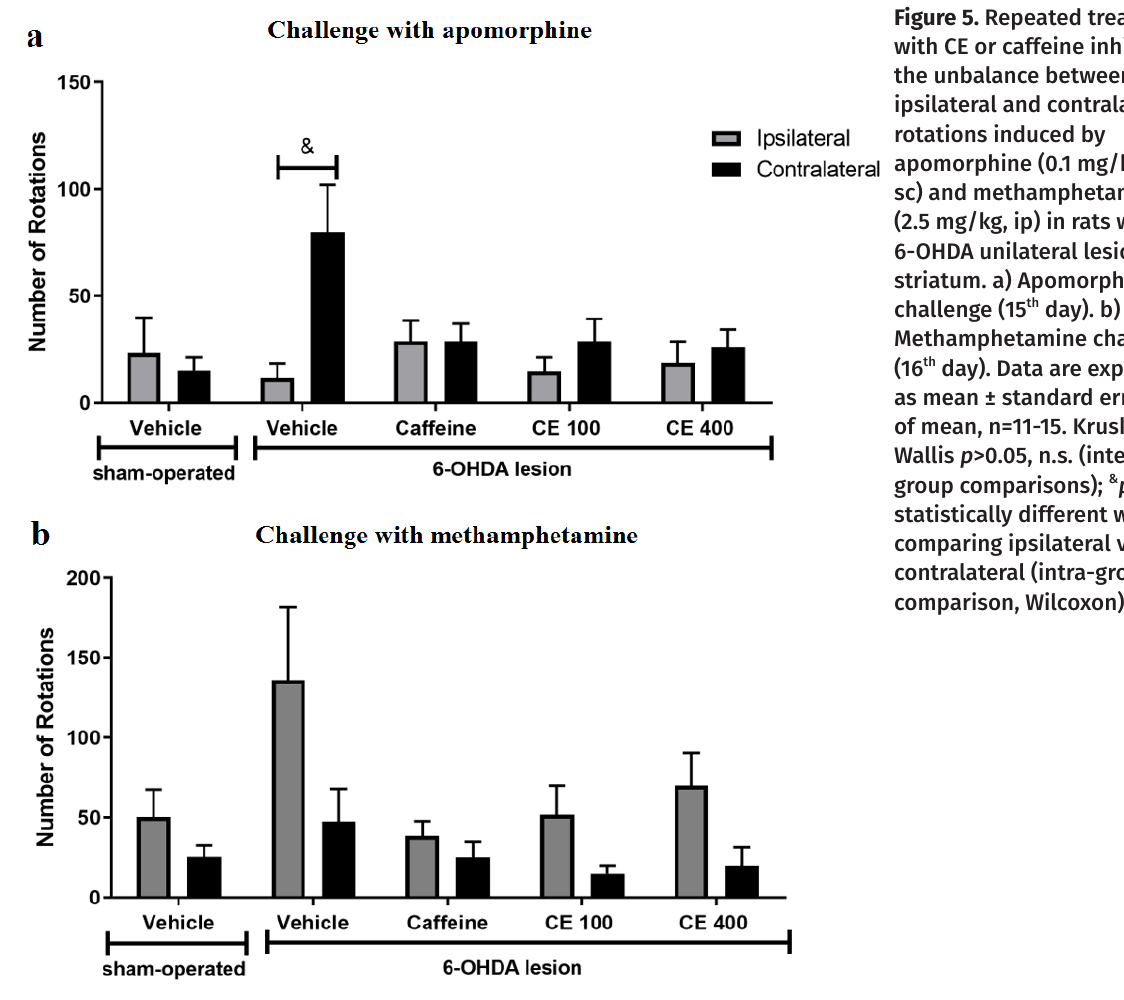
Figure 5. Repeated treatment with CE or caffeine inhibit the unbalance between ipsilateral and contralateral rotations induced by apomorphine (0.1 mg/kg, sc) and methamphetamine (2.5 mg/kg, ip) in rats with 6-OHDA unilateral lesion of striatum. a) Apomorphine challenge (15 th day). b) Methamphetamine challenge (16 th day). Data are expressed as mean ± standard error of mean, n=11-15. Kruskal- Wallis p >0.05, n.s. (inter- group comparisons); & p <0.05 statistically different when comparing ipsilateral vs contralateral (intra-group comparison,